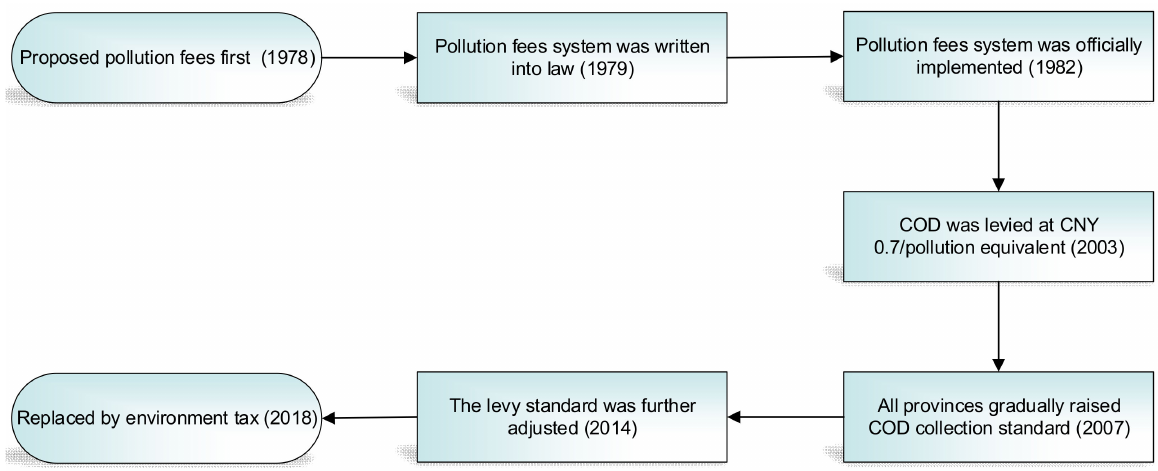
Figure 1. Development history of the pollution fee system in